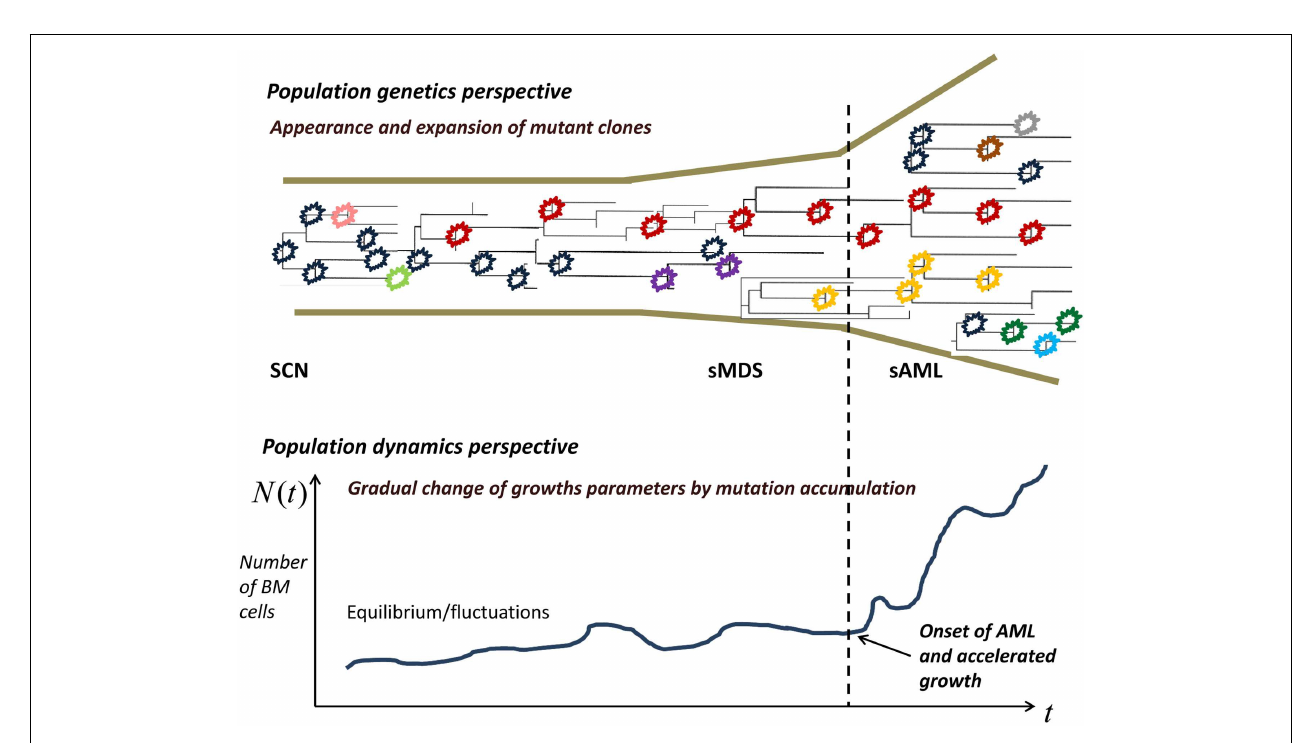
persist.When the population expands, new mutant clones become more easily established. At some point, a qualitative change in the proliferation rate occurs and the now malignant cell population starts rapidly